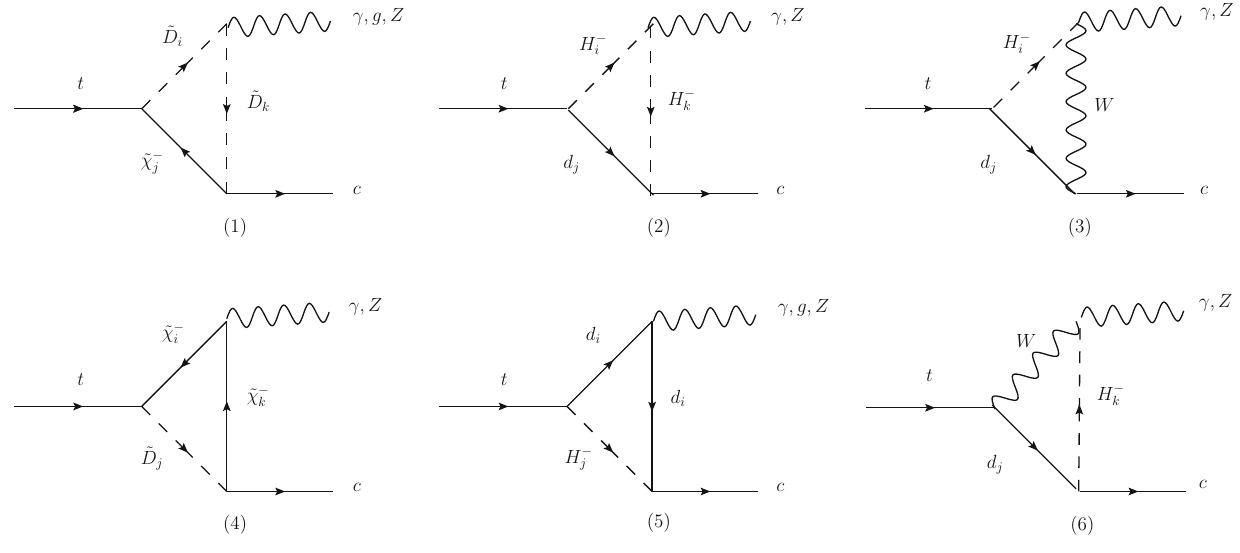
Fig. 1 The dominating Feynman diagrams contributing to t → c γ, g , Z in the